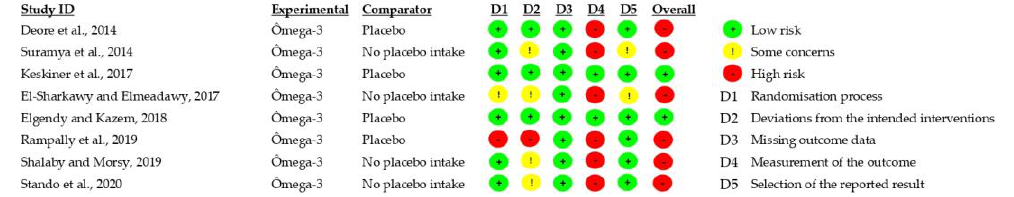
Figure 1. Risk of bias assessment of included